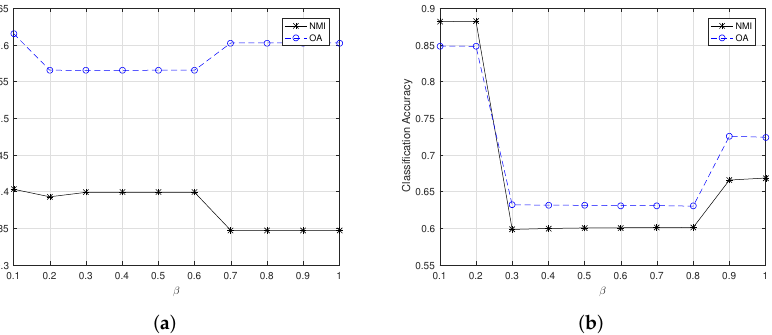
Figure 2. The change of clustering OA and NMI for small-scale HSI datasets yielded by CSSCAG with different β . ( a ) The Indian Pine dataset, ( b ) the Salinas-A